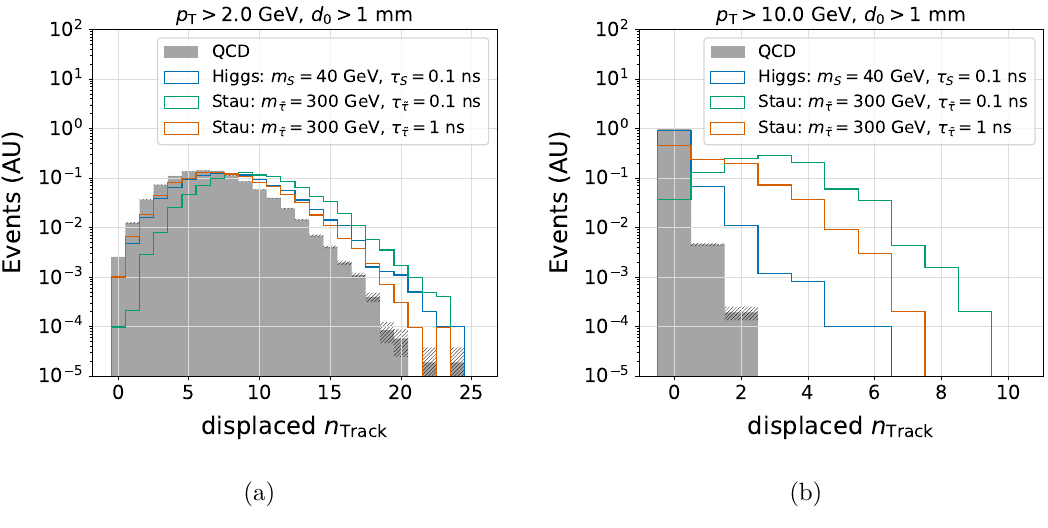
Figure 25. The number of displaced tracks with p T > 2 GeV (a) and p T > 10 GeV (b) per event for minimum bias QCD and representative long-lived signals with pile-up 200. Slashed bands on the QCD distribution represent the statistical